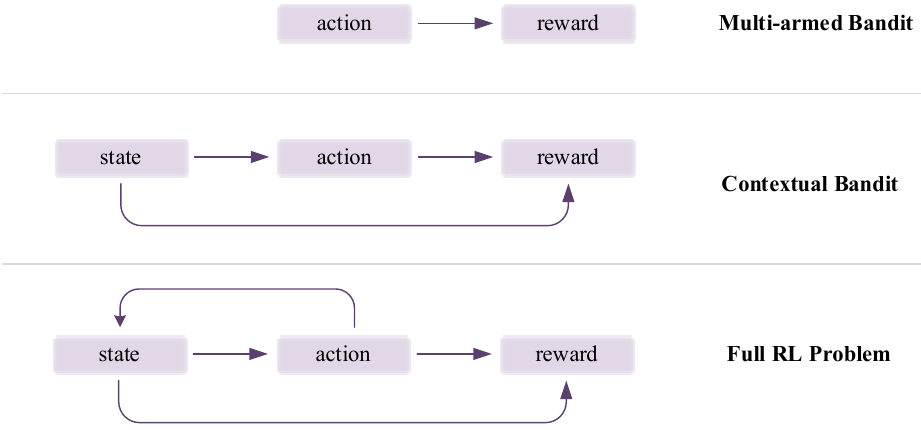
Figure 2. The relationship between state and action in different bandit algorithms.